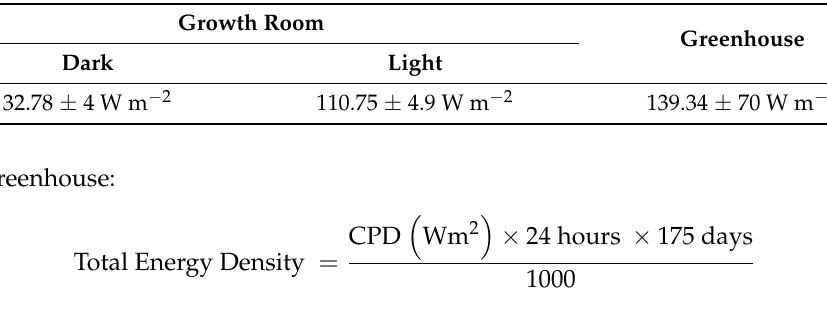
Table 2. Cooling power density of growth room and